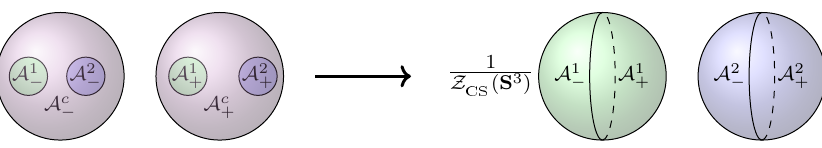
Figure 8 . The (cid:26) for Riemann sphere with two regions A = A 1 [ A 2 and A c with two interfaces A is obtained by gluing the path integrals over the 3-balls by identifying the boundary regions A c and A c on the boundaries. The resultant path integral can be understood as a path integral over + two 3-balls without any identi(cid:12)cation (whose boundaries comprise the components of A ), divided by Z ( S 3 ). This (cid:12)gure also makes it clear that action of (cid:26) CS